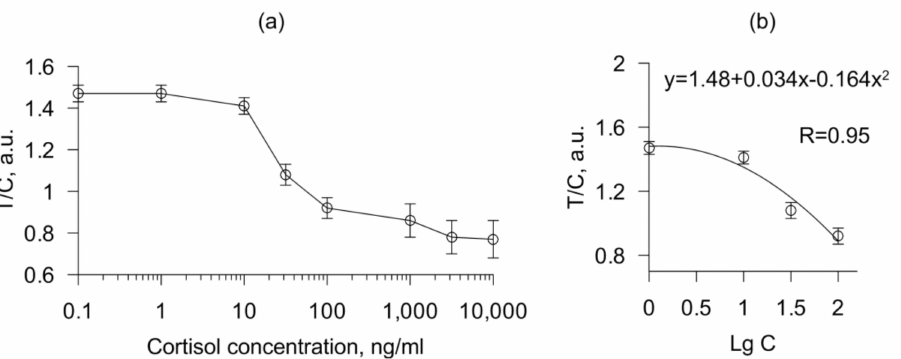
Figure 2. Calibration curve of the immunochromatographic analysis ( a ). A part of the calibration curve in the concentration range from 1 to 100 ng/mL was approximated by a polynomial function ( b ). The abscissa shows the concentration of cortisol ( a ) or log of the cortisol concentration ( b ) in the calibration solution and the ordinate shows the ratio of T to C. Error bars indicate the standard deviations ( n = 3).